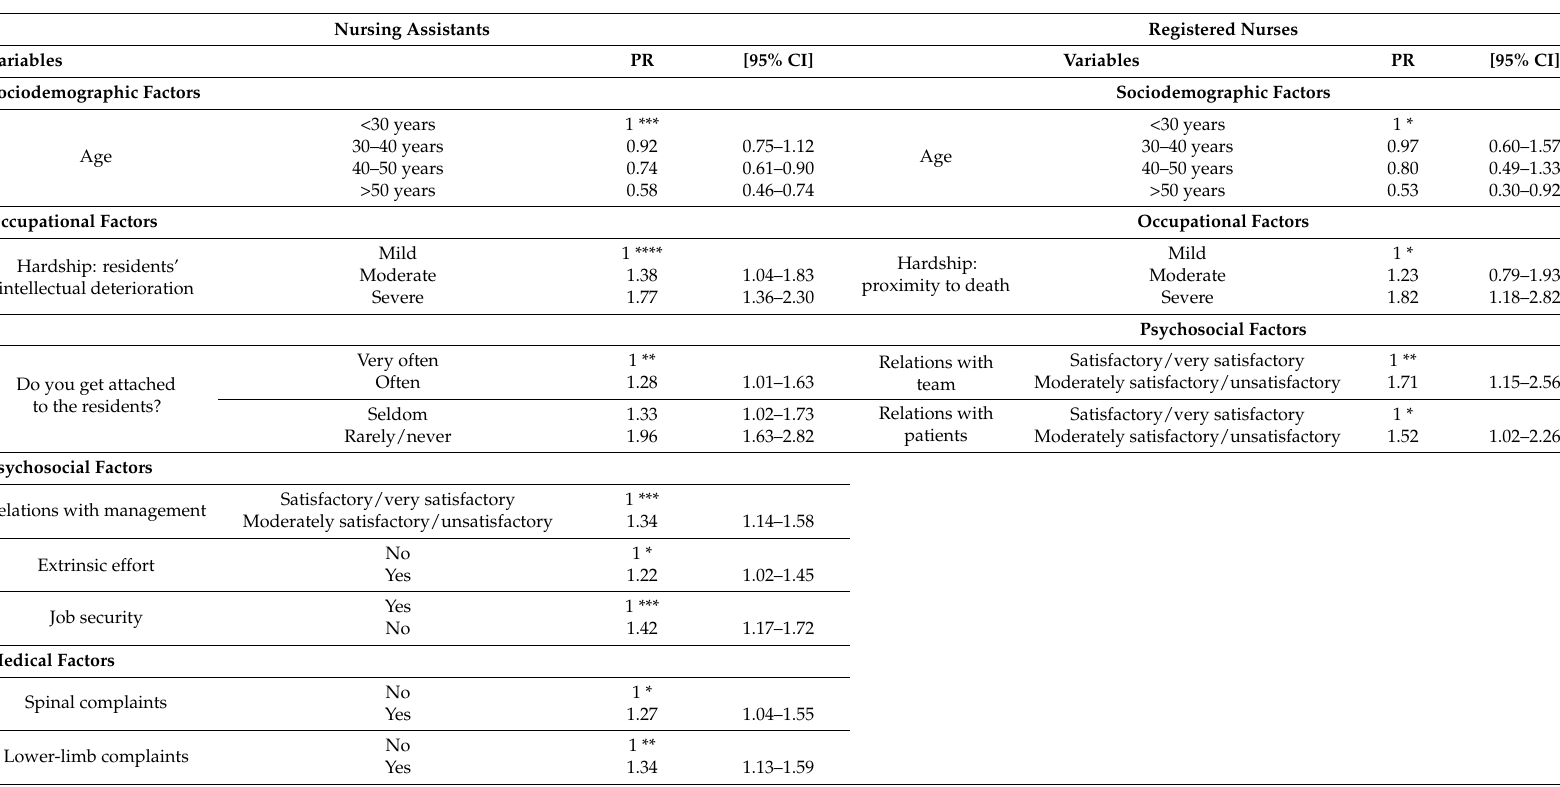
Table 4. Significant associations between registered nurses’ and nursing assistants’ intention to leave work with the elderly and sociodemographic, occupational, psychosocial and medical factors on global multivariate